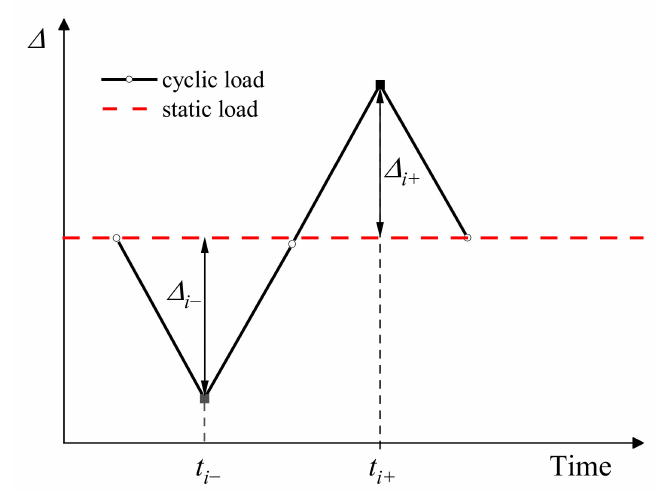
Figure 14. Stiffness degradation parameter diagram.